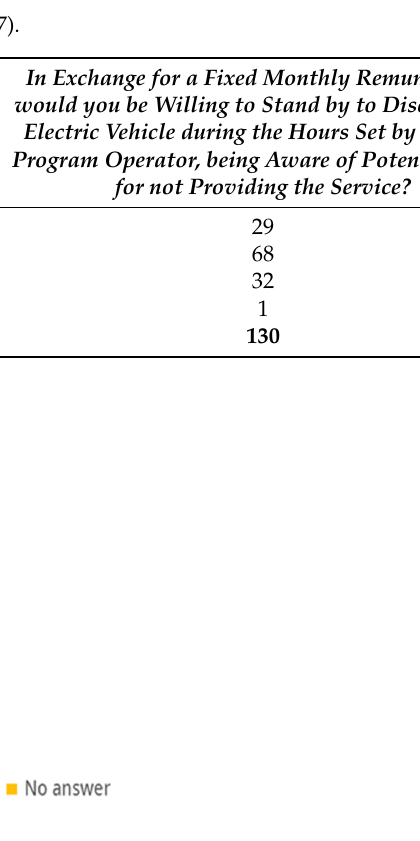
Figure A12. Responses to question (17).